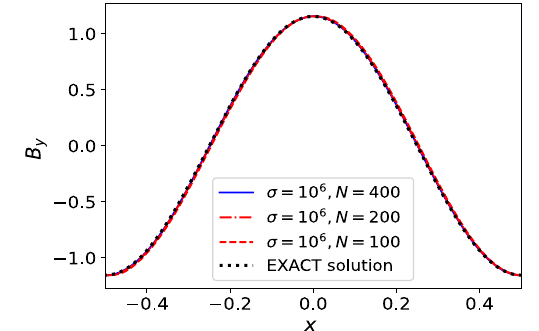
Fig. 3 The L 1 norm errors as a function of the inverse of grid-cell size areshowninthelargeamplitudecircularlypolarizedAlf´venwaves.The two black dashed lines represent the ( − 1 ) and ( − 2 ) analytical